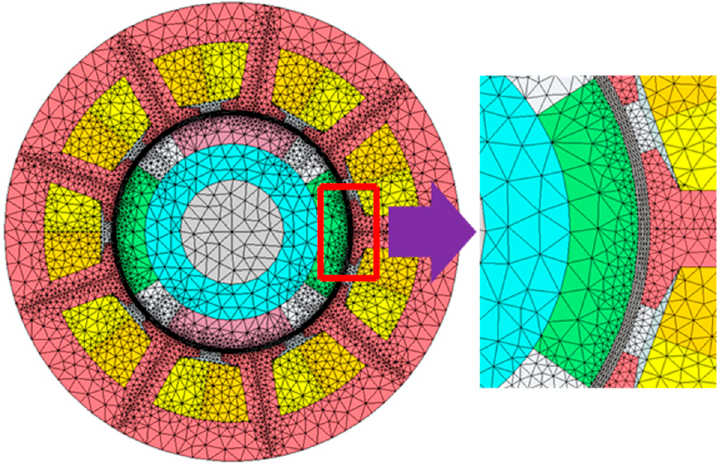
Figure 2. The mesh of motor model.